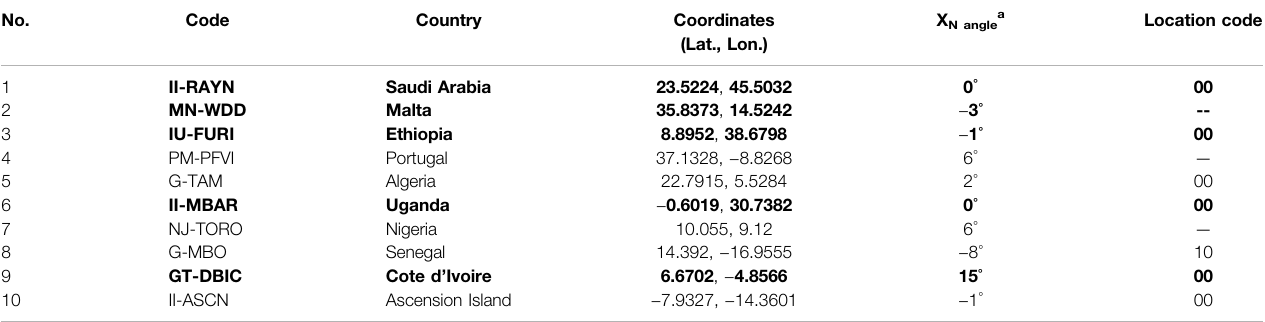
TABLE 1 | Stations used to discriminate local and teleseismic events originating from Western Africa. Station G.TAM has only one horizontal channel, station II.ASCN is an island station, and station PM.PFVI is located in Portugal, but with very little propagation in the Atlantic Ocean. We include II.RAYN, which is a very quiet station, to broaden the back-azimuth coverage, even though it is technically in the Middle East.